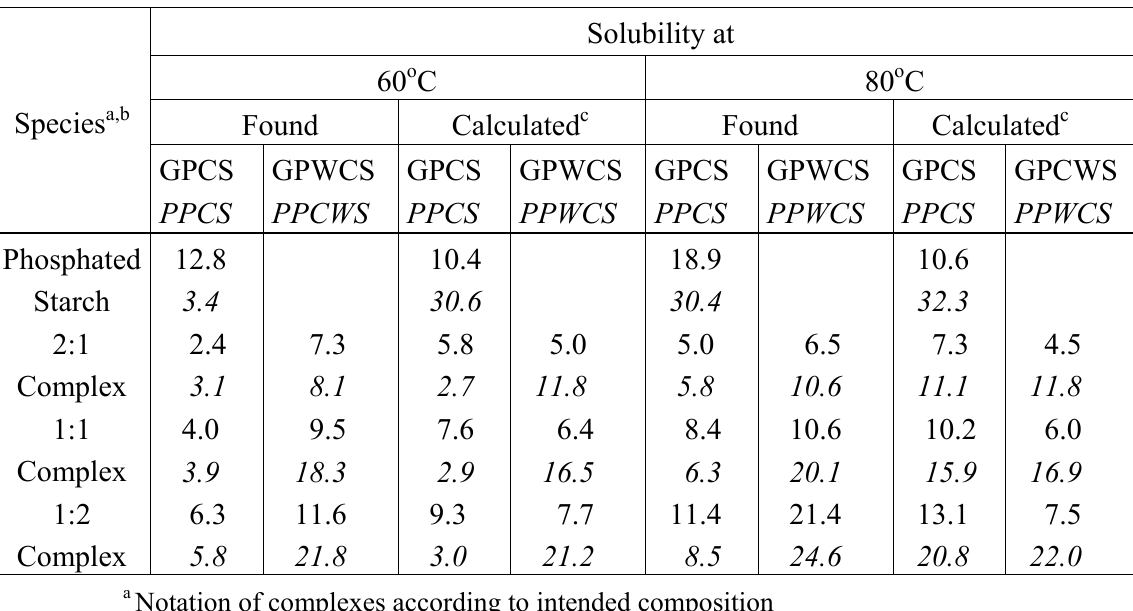
Table 2. Solubility of GPCS, PPCS, GPWCS and PPWCS and their casein complexes in water [g/100g H Found Calculated c Found Calculated c Species a,b